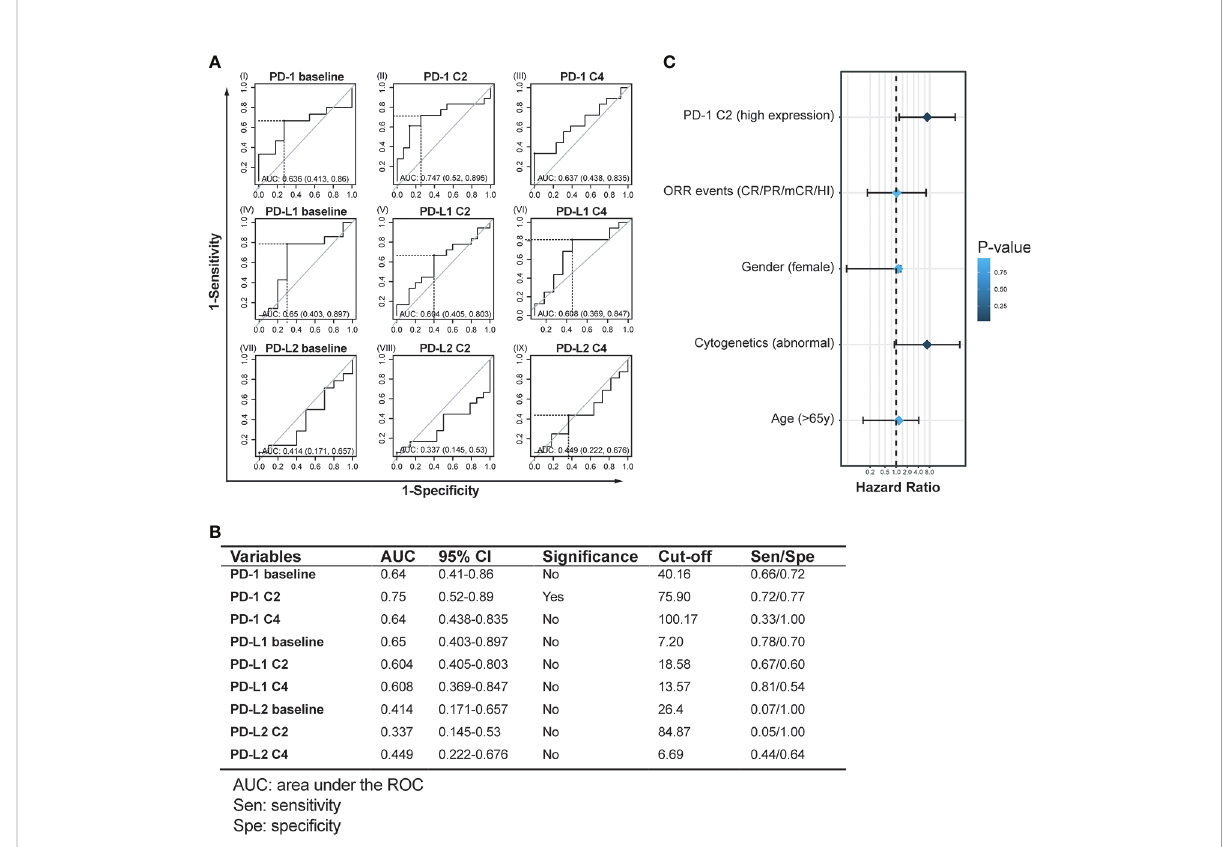
FIGURE 4 Assessment of objective cut-off and prognostic value of PD-1, PD-L1, and PD-L2 expression in HMA treatment cycles. (A, B) Receiver operating characteristic (ROC) curves and statistics of PD-1, PD-L1, and PD-L2 expression at time points predict AML transformation. (C) Binary logistic regression analysis for factors to predict AML transformation in MDS patients treated with